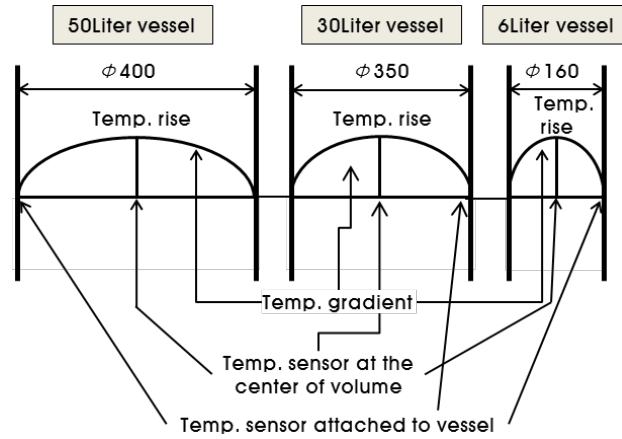
Figure 10. Comparison of the temperature gradients that are assumed to be